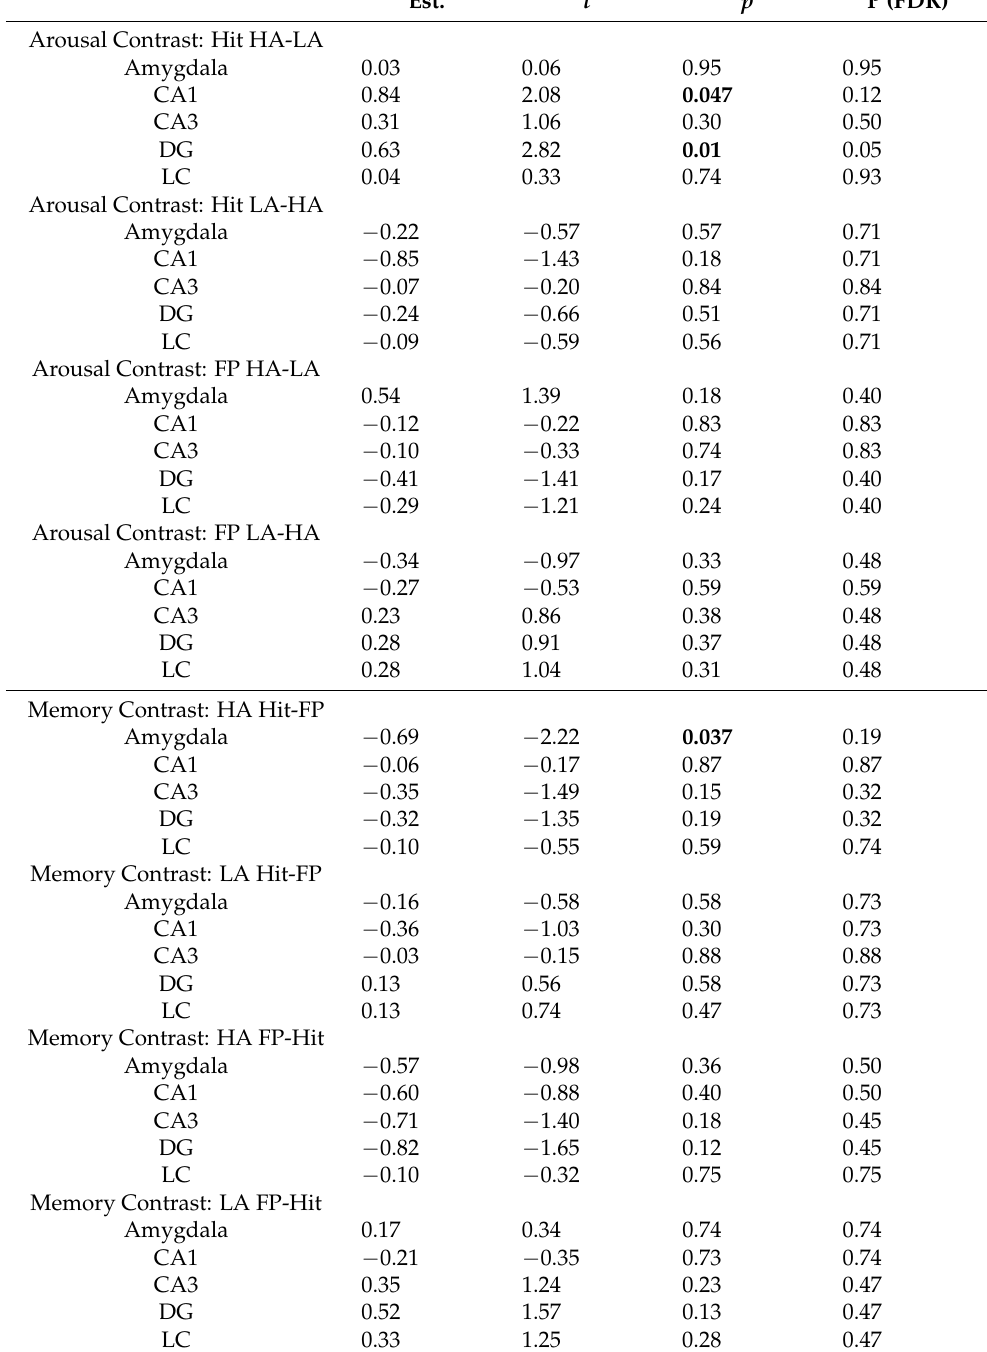
Table 2. Association between arousal or memory-related activity in our ROIs and memory performance.